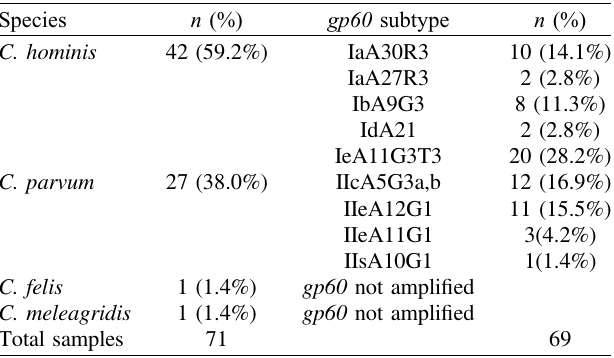
Figure 1. Monthly case number of cryptosporidiosis at the University Teaching Hospital (UTH, Lusaka, Zambia) over the data collection period (bar). Monthly average precipitations (mm) in Lusaka are also indicated on the right (line). Table 2. Species and subtype determination by sequence analysis of small subunit (SSU) rRNA and gp60 loci of Cryptosporidium